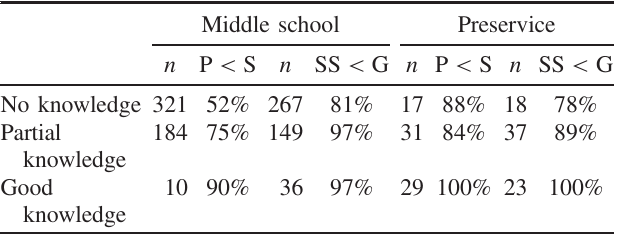
TABLE IV. Correlating students ’ responses to Q5a and